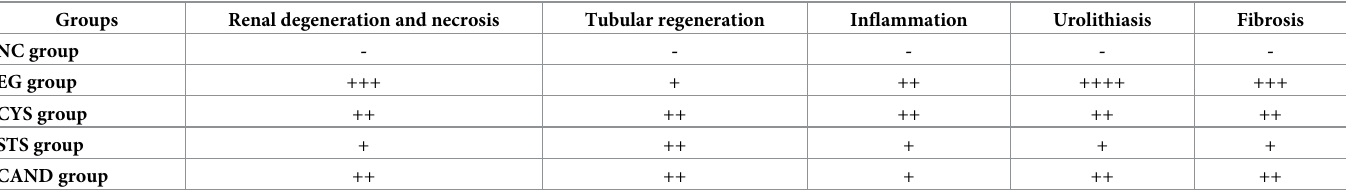
Table 1. Semi quantitative scoring of kidney lesions associated with urolithiasis in different treated groups. Groups Renal degeneration and